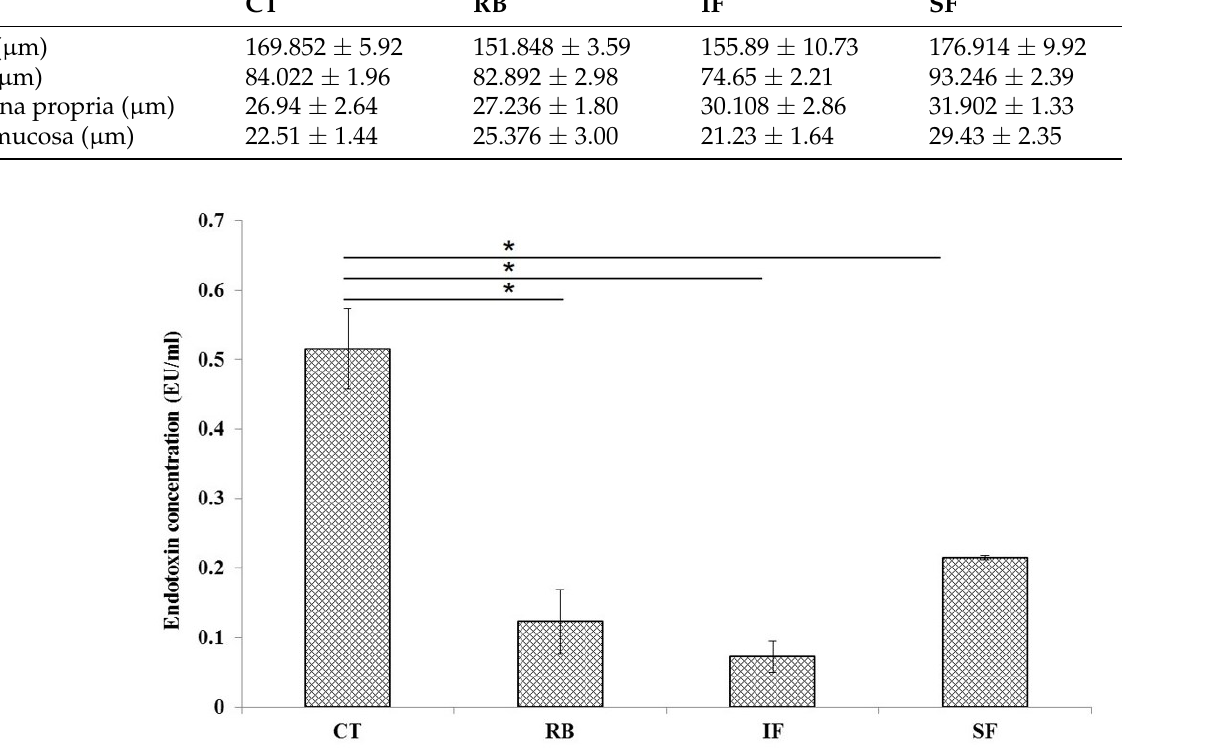
Figure 5. Endotoxin level in the blood plasma of the different groups after 30 days of treat- ment with different fractions of rice beverage. * significant difference ( p ≤ 0.05). (CT = control, RB = rice beverage, IF = insoluble fraction, and SF = soluble